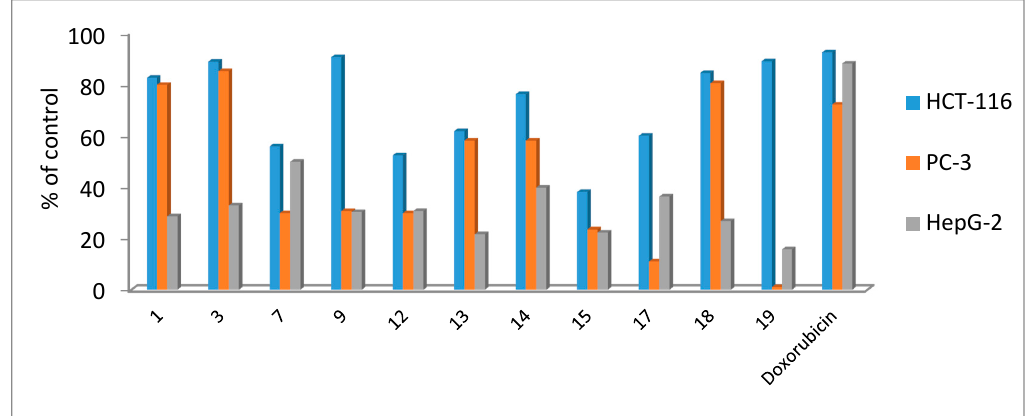
Figure 2. Anticancer activity of compounds against human liver hepatocellular carcinoma (HepG-2), human prostate adenocarcinoma (PC-3) and human colorectal carcinoma (HCT-116) cell lines using a